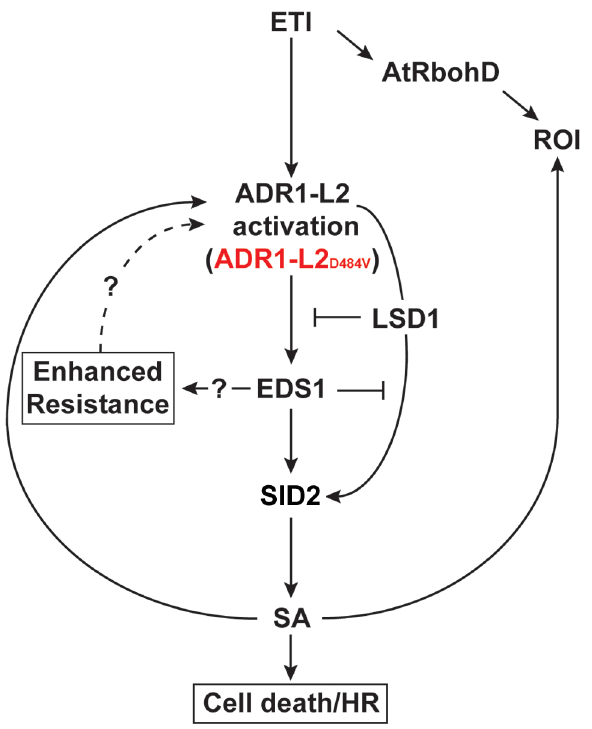
Figure 9. A model for the regulation of ADR1-L2 D484V activity. ETI activates both an AtRbohD-dependent ROI burst and SID2- dependent SA accumulation via ADR1-L2. Activated ADR1-L2 initiates cell death and disease resistance via SA-dependent and -independent pathways. EDS1 functions downstream of activated ADR1-L2 as a positive regulator of both SA accumulation and of the SA-independent pathway. ADR1-L2 also triggers SA via a pathway that is controlled by LSD1 and antagonized by EDS1. Therefore, the spread of this SA accumulation is spatially down-regulated through a combined action of EDS1 and LSD1. Due to its position in these feedback loops, SA functions both up- and down-stream of ADR1-L2.